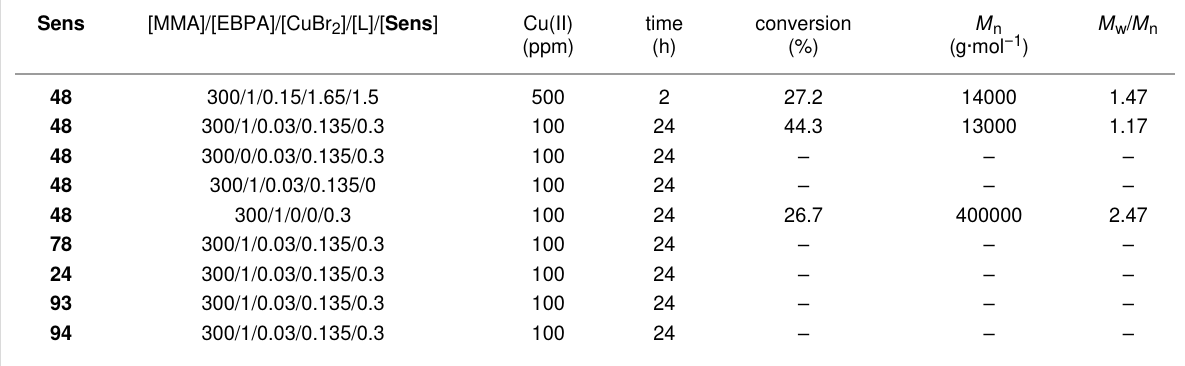
Table 3: NIR sensitized photo-ATRP of MMA under different experimental conditions (L: tris(2-pyridylmethyl)amine) with different sensitizers ( Sens ) [81].